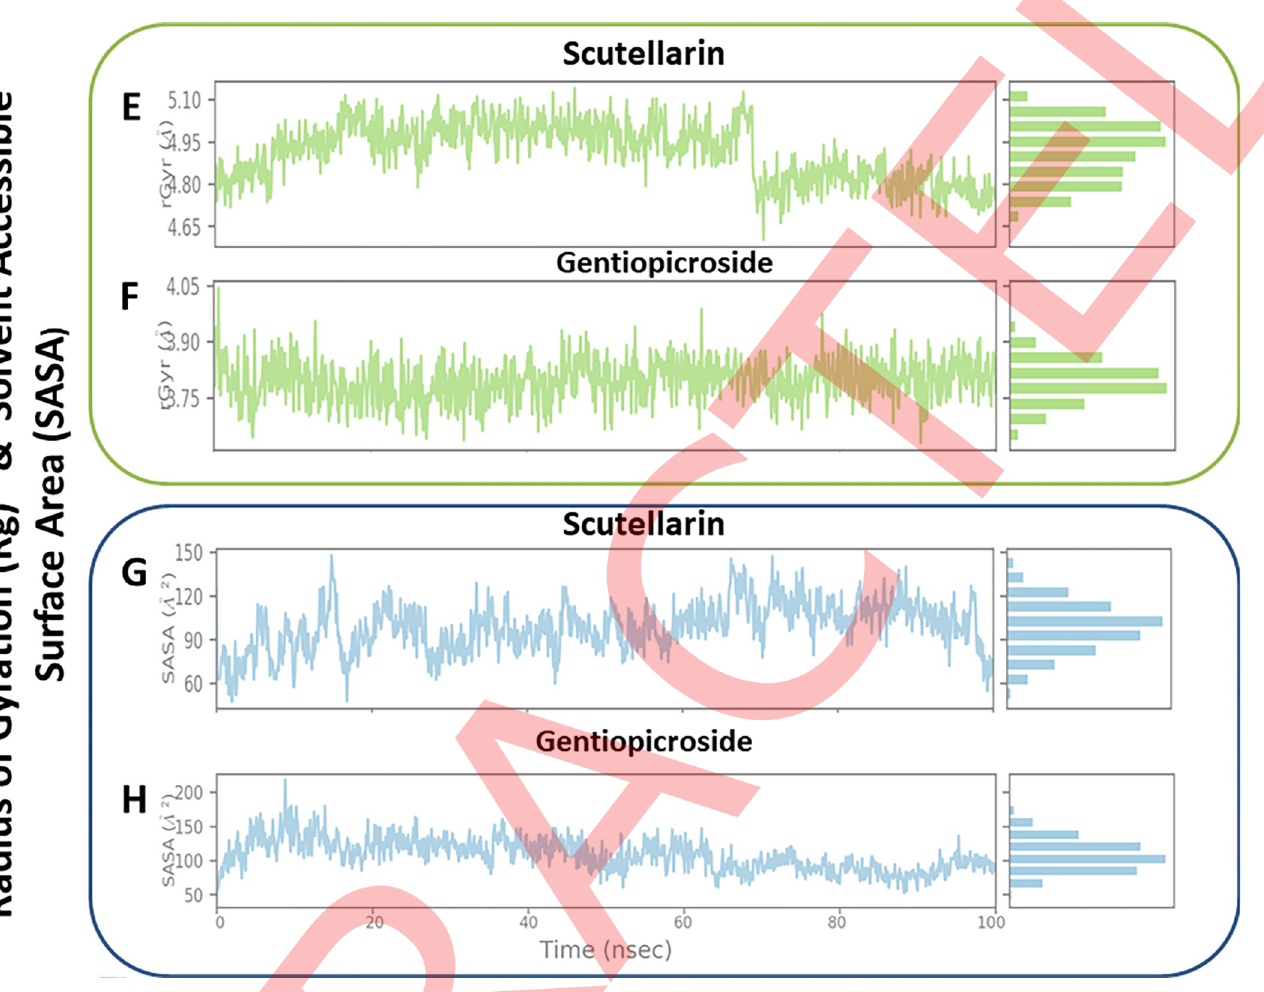
Fig 7. The SASA plots of docked complexes over 100 ns MD simulation and the time frame evolution of 100ns against the radius of gyration (Rg) (E & F) (G &